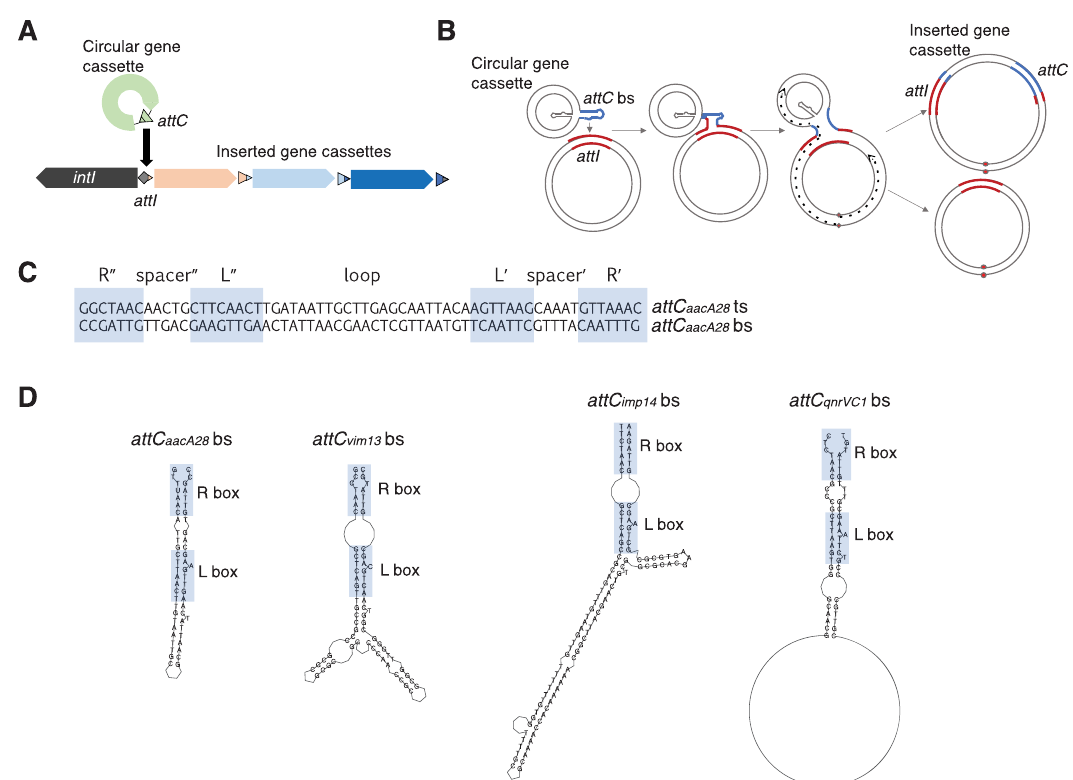
Fig. 1 The role of attC folding structure in gene cassette insertion. A Integrons carry an integron integrase gene ( intI ) that encodes a tyrosine recombinase (IntI). IntI facilitates the insertion of circular gene cassettes by mediating recombination between the cassette-associated recombination ( attC ) and integron-associated recombination ( attI ) sites. IntI activity can result in arrays of gene cassettes that vary considerably in size (1 to + 300). B Cassette insertion involves the recombination between attI and only the bottom strand of attC ( attC bs). This results in an atypical Holliday junction, which can only be resolved by replication (dotted black arrows; lagging strand not shown). Replication of the recombinogenic strand produces a daughter molecule with the inserted cassette at the attI site, while replication of the alternate strand generates the integron without the inserting cassette. C The palindromic nature of attC s gives rise to their single-stranded folding structure. All attC sites have two sets of inverted repeats (R ′ /R ″ and L ′ /L ″ ), which allow the folding of single-stranded attC s. Two spacers, spacer ″ and spacer ′ , separate R ″ from L ″ and L ′ from R ′ , respectively. The middle region of the attC is known as the loop and is highly variable in sequence and size. D Shown are the predicted bottom strand folding structures of attC s from four antibiotic resistance gene cassettes ( aacA28 , vim13 , imp14, and qnrVC1 ). The variable degree of base-pairing beyond the R and L boxes generates considerable structural diversity among different attC s, which in turn impacts their recombination ef fi ciency by different IntIs. Folding structures were predicted by RNAfold v 2.4.16 from the ViennaRNA Package 2.0 40